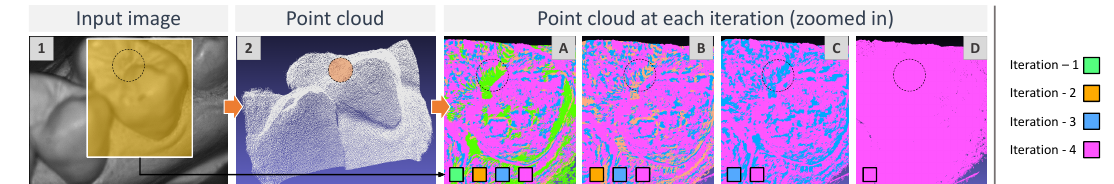
Figure 6. Input image, point cloud(without post-processing) and zoomed-in version of point cloud result of each iterations. Iteration 1-green, 2-yellow, 3-blue, 4-purple. A—includes all iterations’ result,